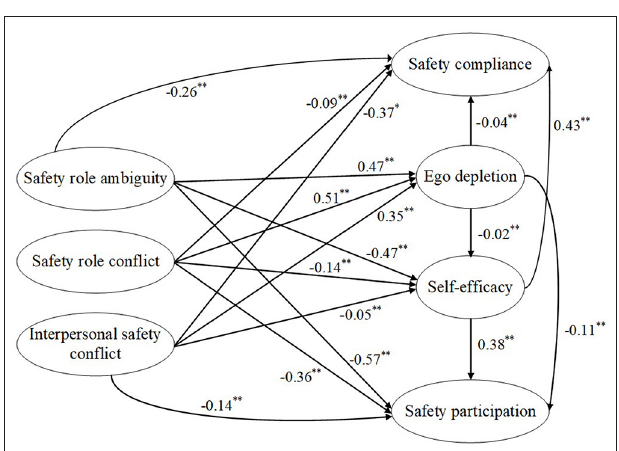
FIGURE 4 | Direct effects of safety stressors on self-efficacy. ** p < 0.01.